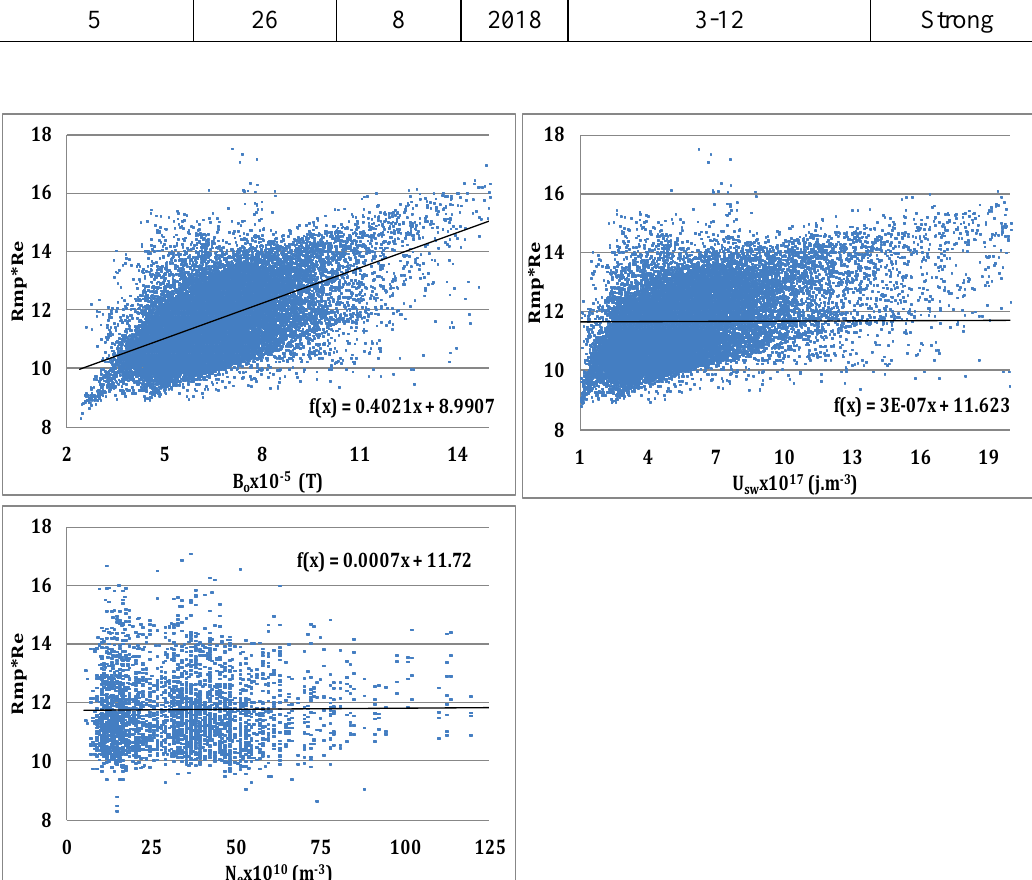
Fig.2: Hourly average of Earth's (R